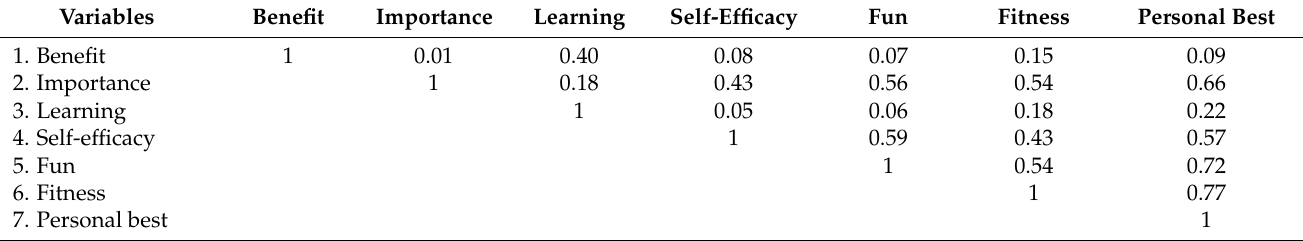
Table 3. Standardized factor correlation of the final measurement model of the